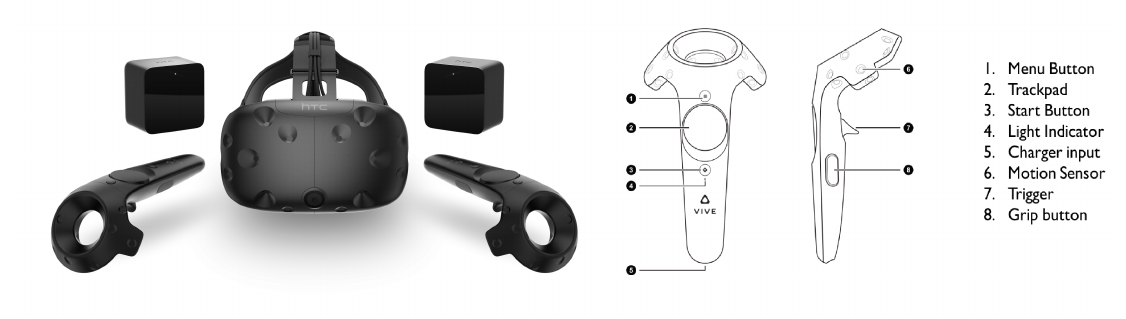
Figure 6. HTC Vive headset and